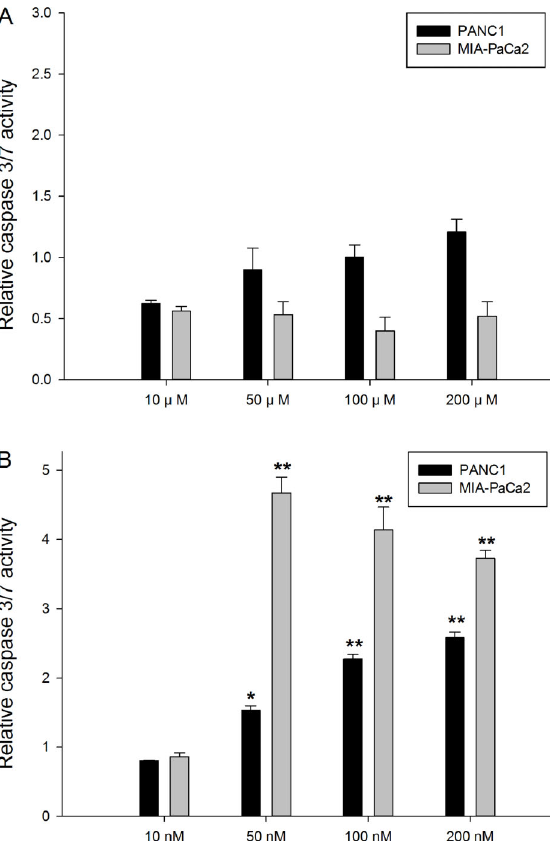
Figure 5. Caspase 3/7 activity analyses of PANC-1 and MIA- PaCa2 cells after 72-h treatment with berberine ( A ) and with gemcitabine ( B ). Data are reported as mean activity (n > 3) relative to control ± SD. *P , 0.05, **P , 0.01 versus control (Student’s t -test).